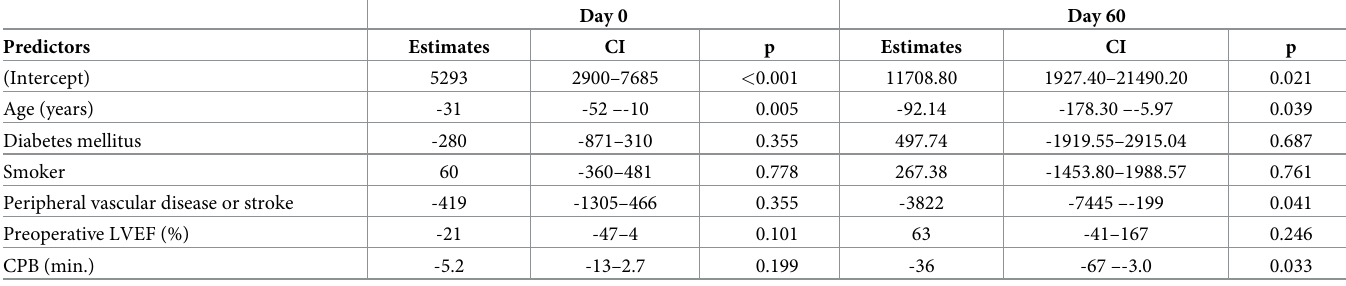
Table 2. Multivariate linear regression model predicting daily